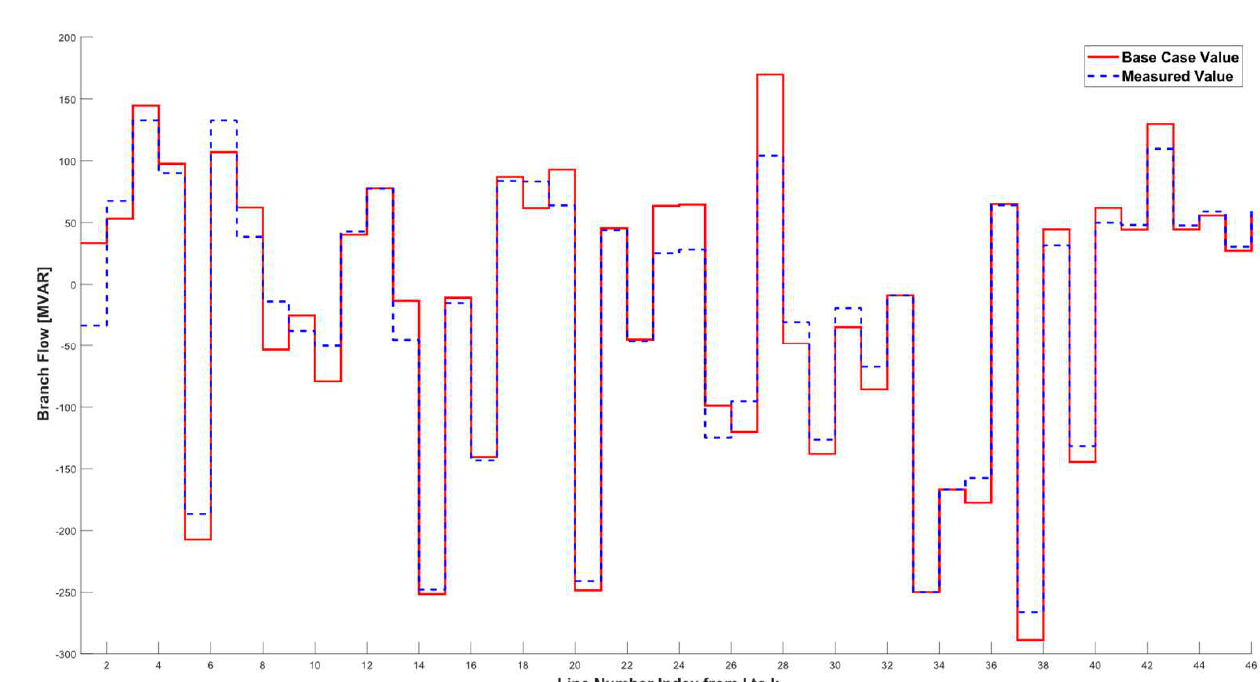
Figure A2. Sensitivity-based analysis and measured MVAR flow data comparison.